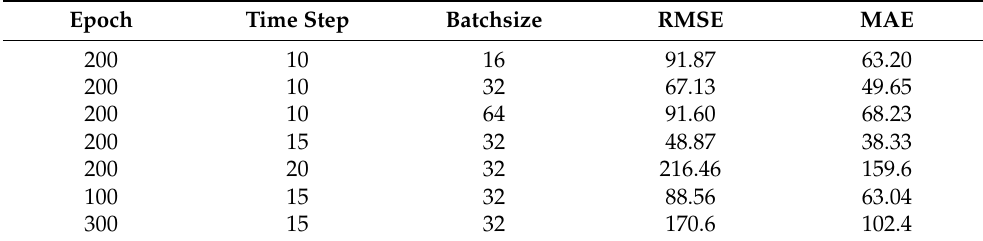
Table 7. Comparison of prediction errors under different parameter